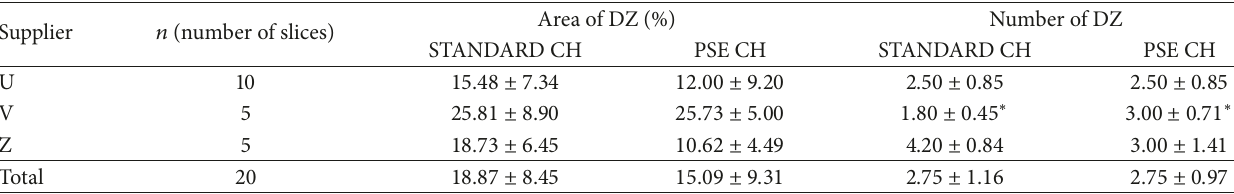
Table 5: The number and area of destructured zones (DZ) in hams (means ± S.D.). The occurrence of destructured zones was evaluated in 20 slices of STANDARD CH and 20 slices of PSE CH with the use of image analysis. The area covered by destructured zones was indicated in % on each slice and their total area on the